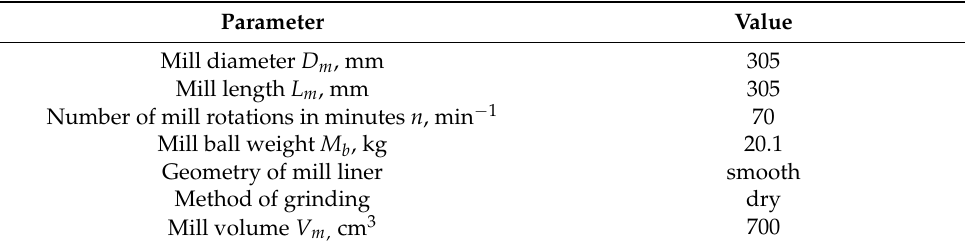
Table 1. Bond’s mill specification and grinding condition.